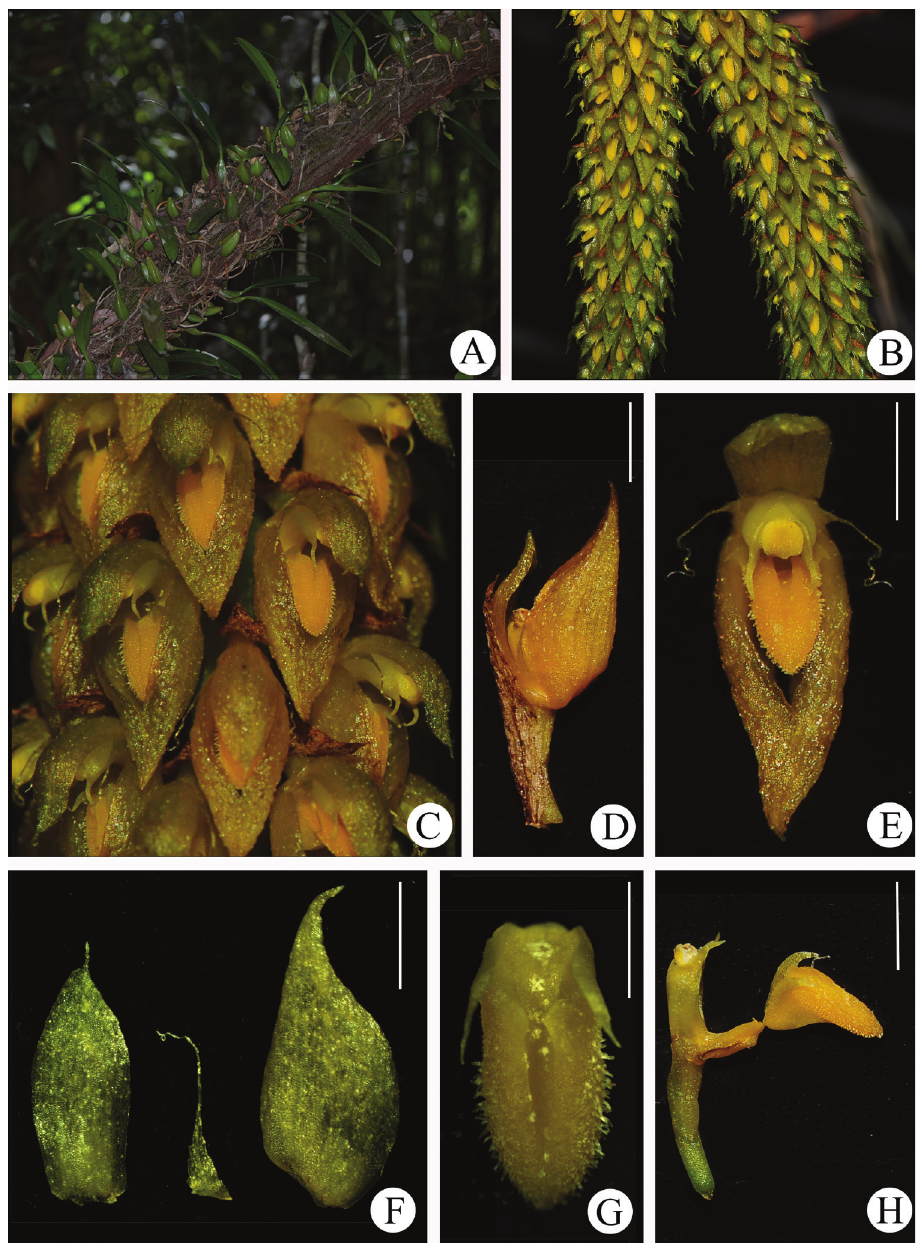
Figure 2. Bulbophyllum chrysolabium. A Habitat B Inflorescences C Close-up of inflorescence D Flower, lateral view showing floral bract E Flower, frontal view F Dorsal sepal, petal and lateral sepal, abaxial view G Lip, ventral view H Column and lip, lateral view. Scale bars, 1 mm ( G ), 2 mm ( D–F, H